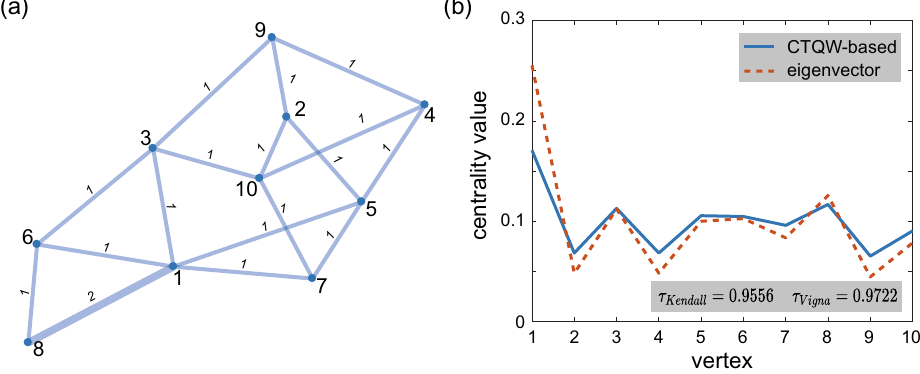
Figure 2. ( a ) A randomly generated Erdős-Rényi graph ER (10, 0.3) with an additional weight w = 2 added on a random edge. ( b ) The eigenvector centralities (dotted red line) and CTQW-based centralities (solid blue line) for vertices of the graph in ( a